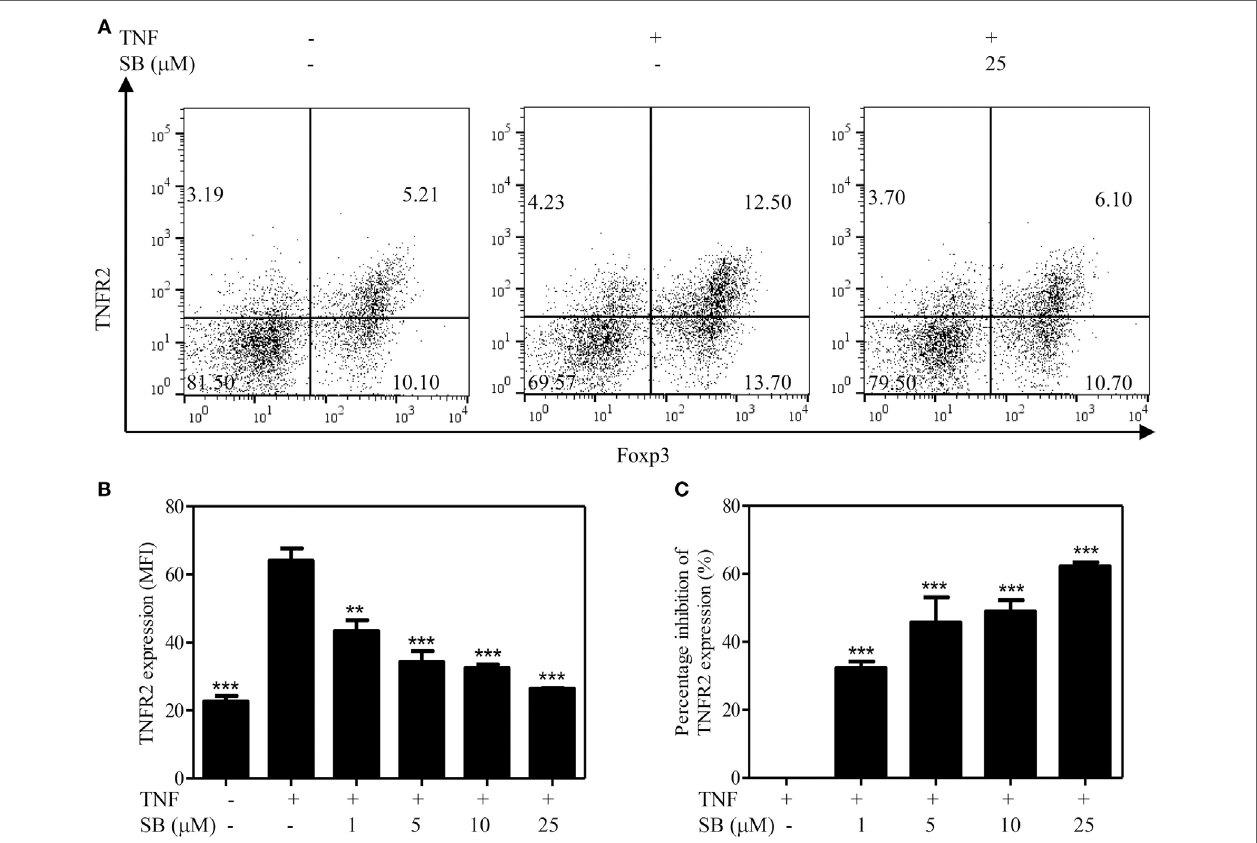
FigUre 3 | Upregulation of TNFR2 expression on regulatory T cells (Tregs) induced by tumor necrosis factor (TNF) is abrogated by SB203580. MACS-purified CD4 + T cells were cultured in the presence of IL-2 (10 ng/mL), or IL-2 + TNF (10 ng/mL, each), with medium alone or with SB203580 (1–25 µM). The cells were cultured for 72 h. The surface expression of TNFR2 and intracellular expression of Foxp3 were analyzed with FACS. (a) Typical FACS dot plot of TNFR2 and Foxp3 expression. Data shown are representatives of at least three separate experiments with similar results. Number in the FACS plot shows the proportion of cells in the respective quadrants. (B) Summary of mean fluorescence intensity (MFI) of TNFR2 expression on Tregs (by gating on Foxp3 + cells. N = 3, means ± SEM). (c) Percent inhibition of TNFR2 expression on Foxp3 + Tregs ( N = 3, means ± SEM). The formula used to calculate percent inhibition is: (A − B)/A × 100%, A is MFI of TNFR2 expression treated with TNF/IL-2, B is MFI of TNFR2 expression treated with SB203580 (1–25 µM) + TNF/IL-2. By comparison with “TNF + IL-2” group, ** p < 0.01, *** p < 0.001. Data shown are representatives of at least three separate experiments with similar